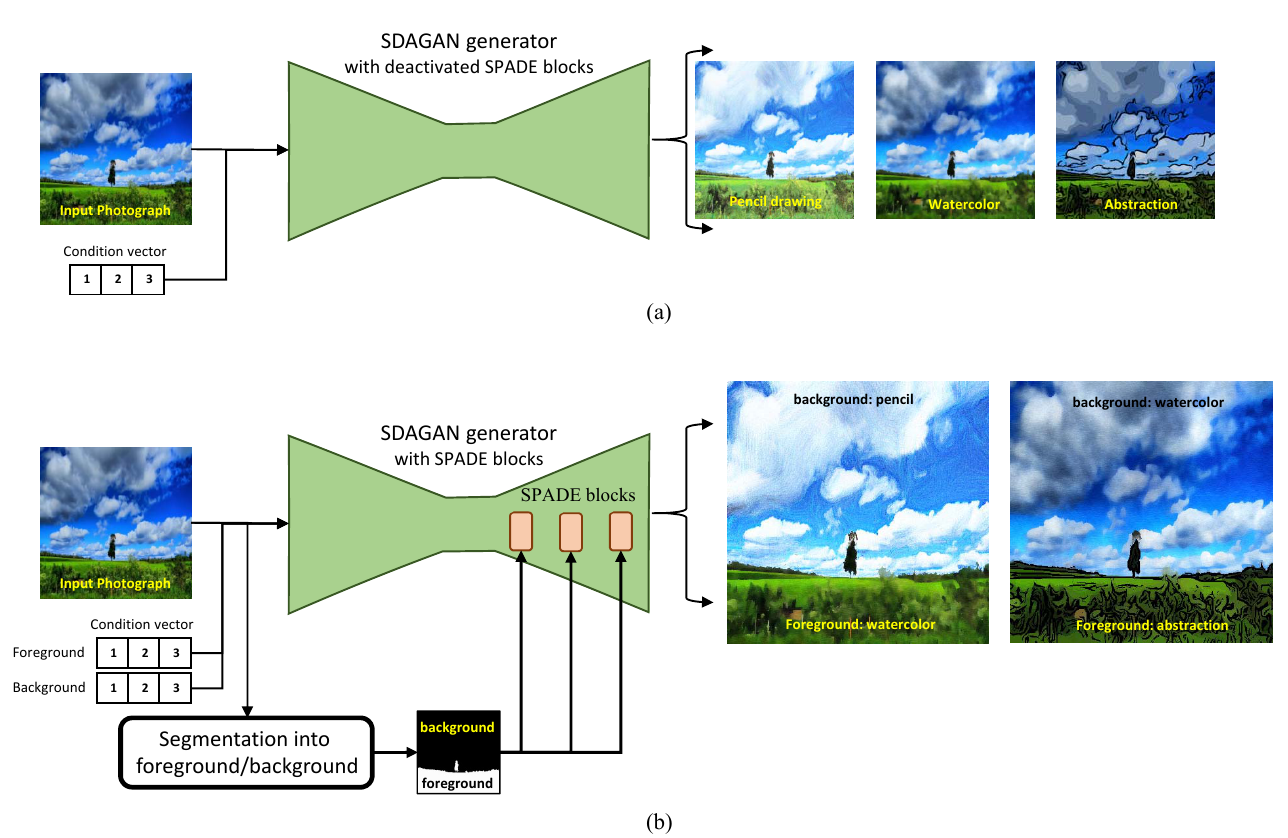
Figure 1. The overview of our framework: ( a ) single artistic effect generation using SDAGAN generator with deactivated SPADE blocks (The control vectors are used to specify user-desired effect), ( b ) dual artistic effect generation using SDAGAN generator with SPADE blocks (The segmentation map is employed in the SPADE blocks to apply different artistic media